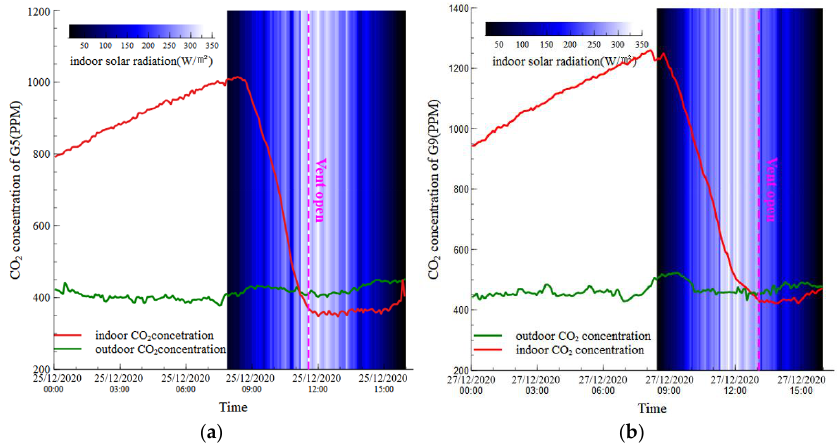
Figure 10. Data on CO 2 concentration and solar global radiation. ( a ) CO 2 concentration data of G5; ( b ) CO 2 concentration data of G9. ( b ) CO 2 concentration data of G9.